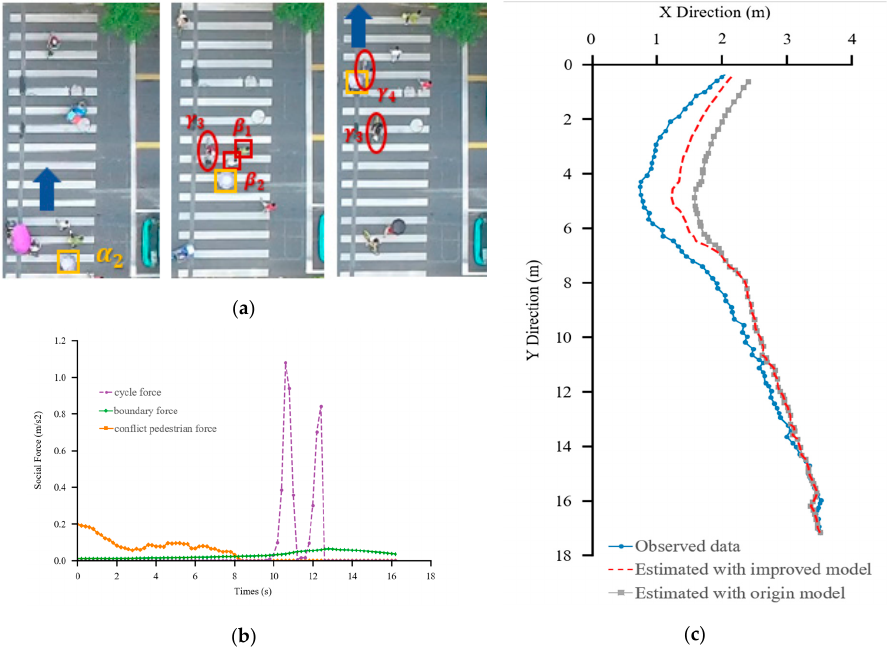
Figure 9. Illustration of the modeled pedestrian movements affected by the boundary, cyclists, and other pedestrians. ( a ) The recognized pedestrian and cyclists. ( b ) Forces exerted by the boundary, cyclists, and pedestrians in the improved SFM. ( c ) Comparison of traditional and improved social force models.